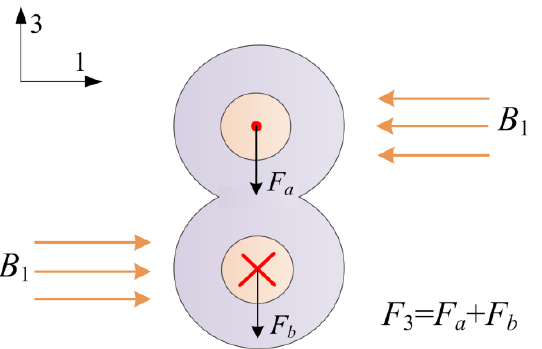
Figure 2. Superimposition of the Ampere forces on the two conductors of the power cord.